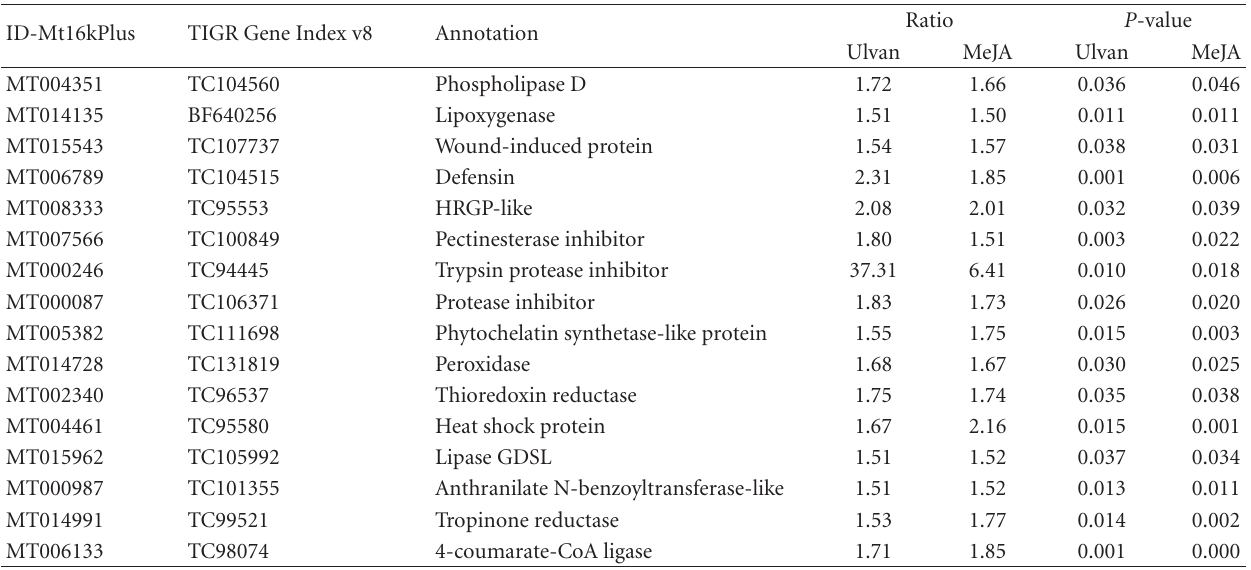
Table 3: Defense genes upregulated after ulvan or MeJA treatments of M. truncatula.